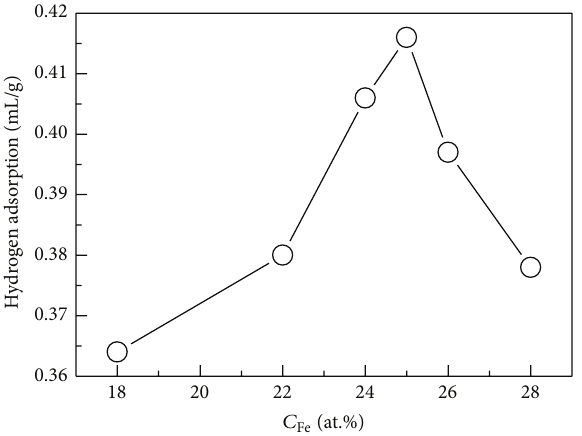
Figure 8: The curves of the quantity of hydrogen adsorption per gram for the ordered Ni 3 Fe powder versus Fe stoichiometry.